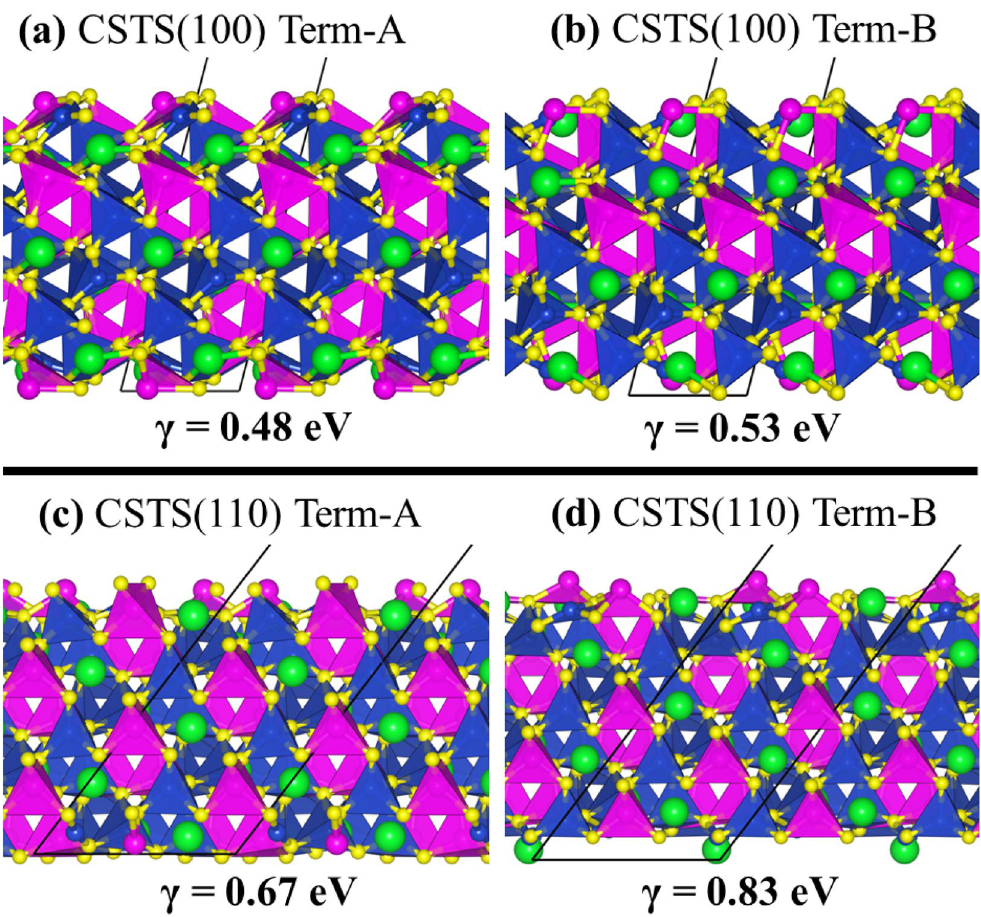
Figure 5. Side views of the relaxed structures of the (100) and (110) surfaces of Cu 2 SrSnS 4 . Images produced using VESTA-ver.3.5.7. 38 .